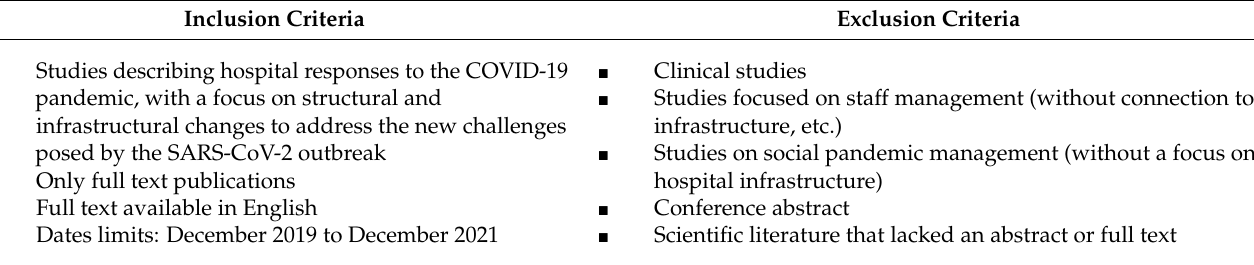
Table 1. Inclusion and exclusion criteria for study